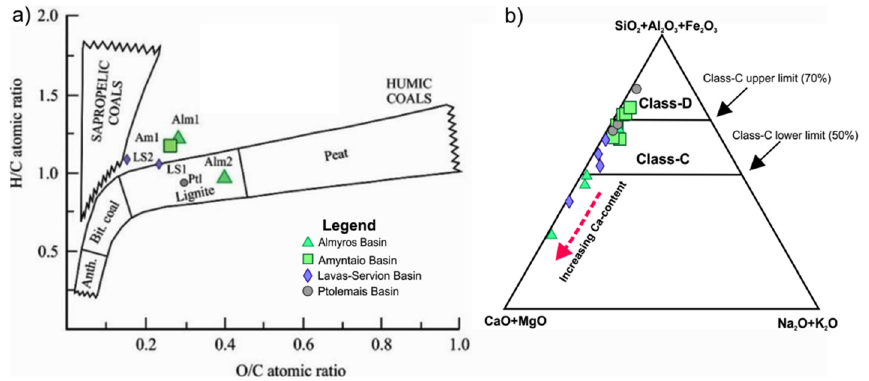
Figure 2. ( a ) Van Krevelen classification diagram of O/C vs. H/C atomic ratios plots for the coal deposits under study; ( b ) Ternary classification diagram for coal fly ashes. Table 1. Averaged physicochemical qualitive data of the coal seams from the Mesohellenic